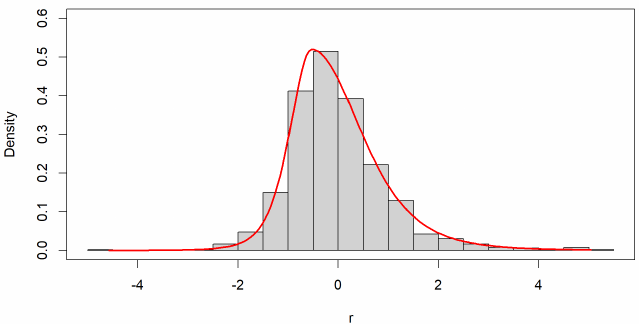
Figure 3. Skewed Student-t Distribution.